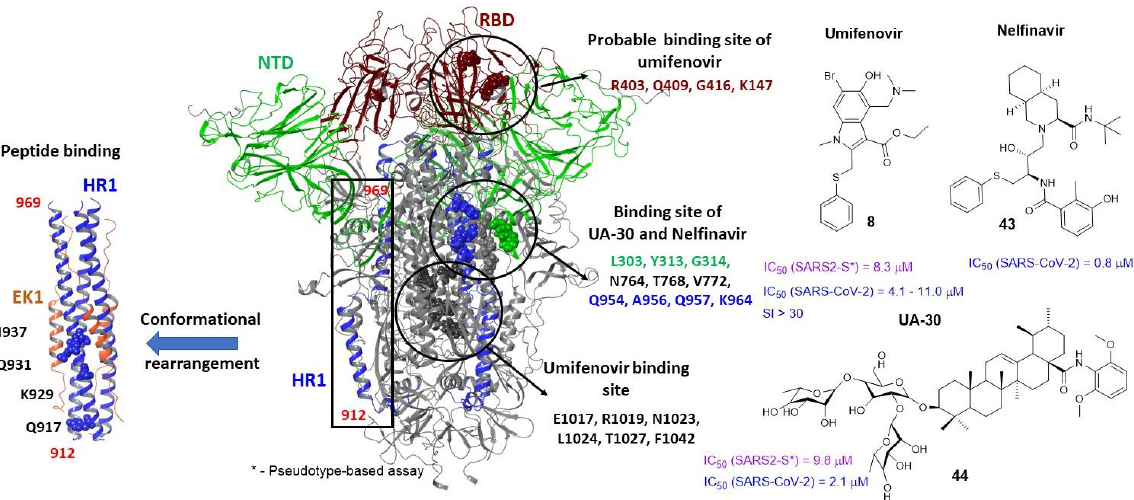
Figure 15. Binding sites of a number of S 2 -protein fusion inhibitors. Key amino acids are indicated. The HIV-1 protease inhibitor nelfinavir ( 43 ) also inhibits protease 3CL of SARS-CoV-1 4.1 and 11.0 μМ (Fig ure 15) [107,108]. Based on molecular modeling data [109], a possible